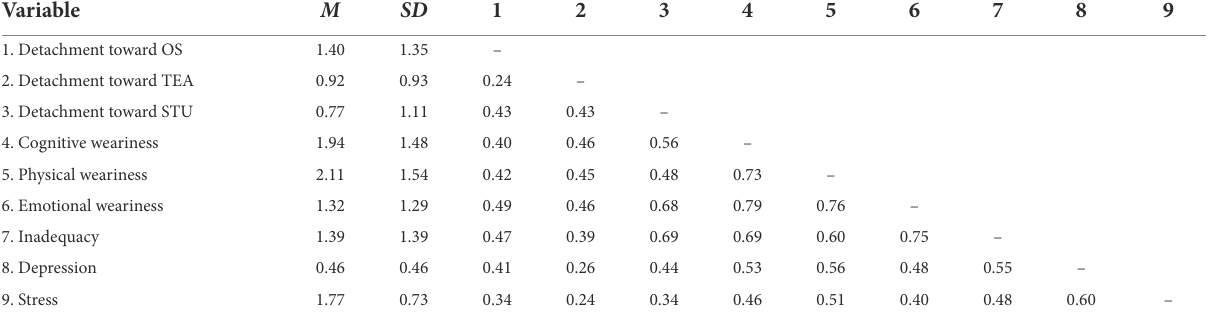
TABLE 2 Correlations between variables. Variable